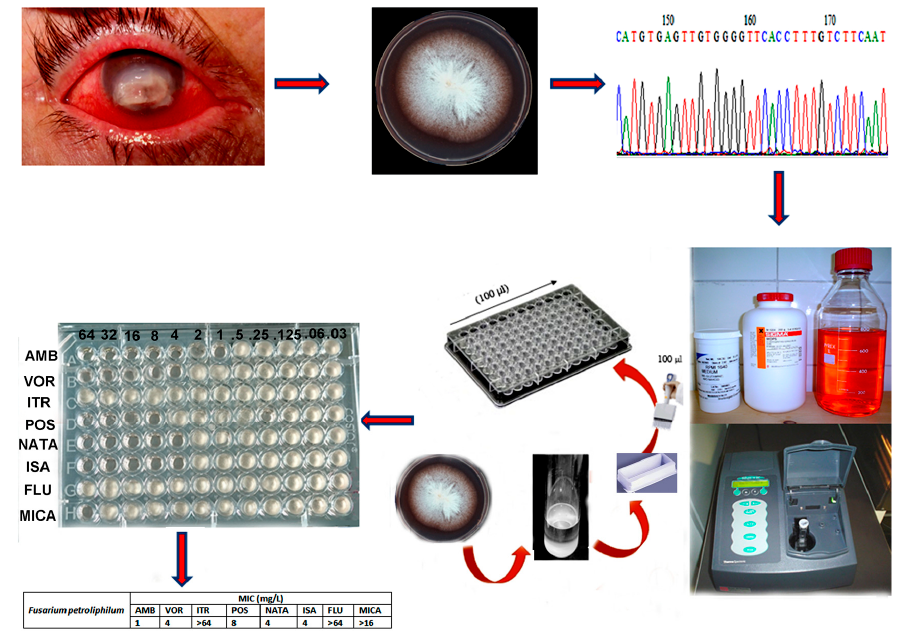
Figure 1. Antifungal susceptibility testing workflow.